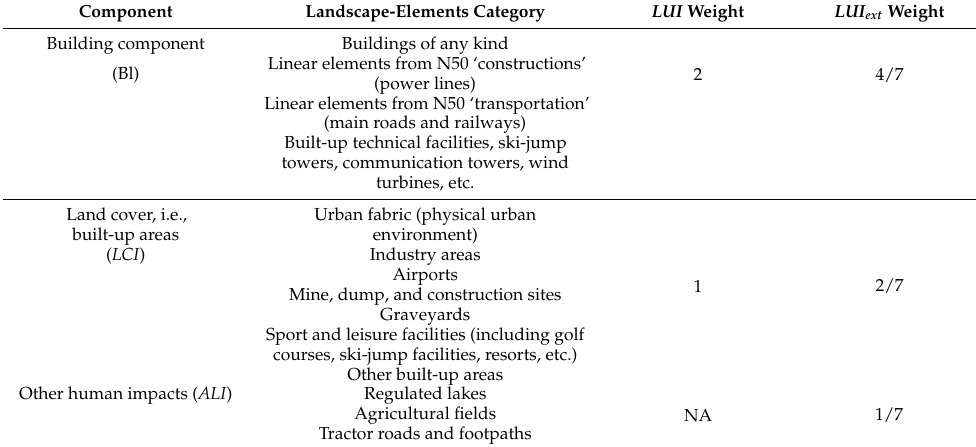
Table 1. Landscape elements included in each component of the human land use ( LUI ) index. The data are included in the official topographic map of Norway and the data are downloadable in different GIS formats from https://www.geonorge.no/ (accessed on 10 January 2023) as part of the Norwegian official map strategy [33]. The data structure and quality are defined in the Norwegian SOSI standard [34]. The dataset “regulated lakes” is obtained from The Norwegian Water Resources and Energy Directorate: